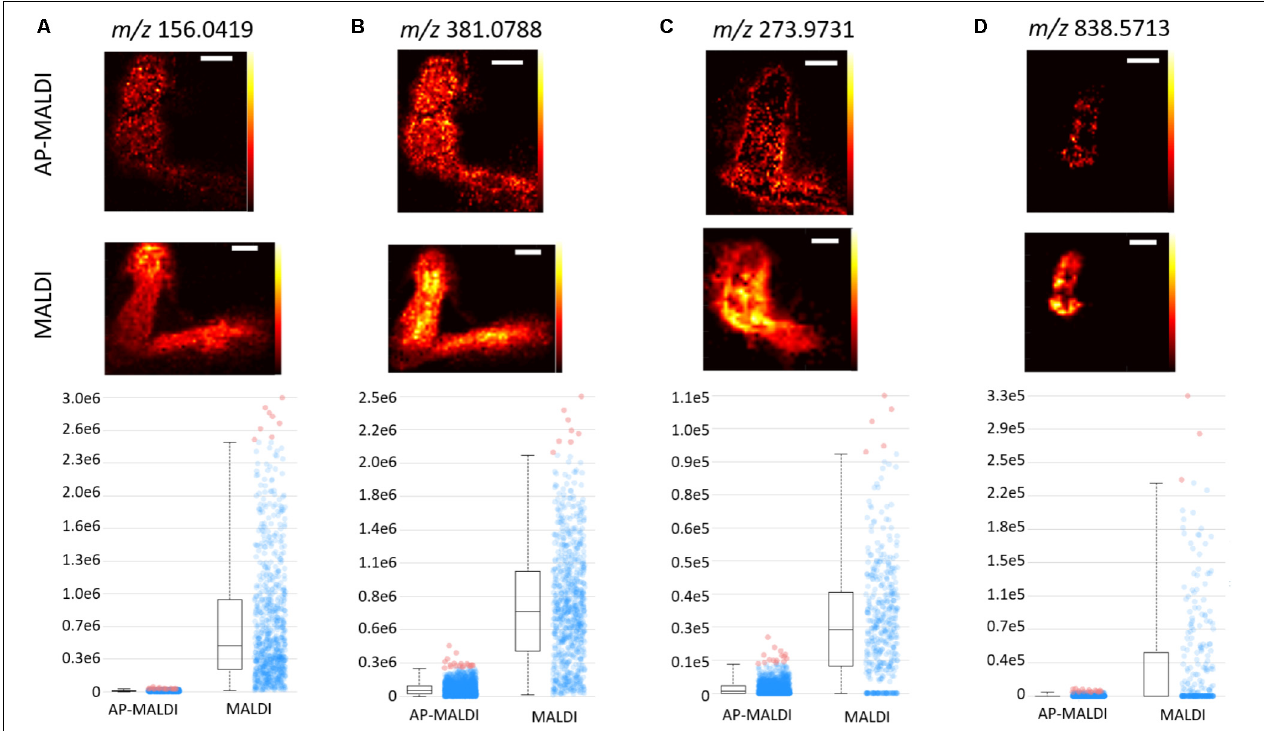
FIGURE 3 | Comparison of images detected in both the AP-MALDI and MALDI platforms. Each part in (A–D) depicts a different m/z with a ± 5 ppm window. For each part, the AP-MALDI image is shown on the top, the MALDI image in the middle, and the box and whisker plot on the bottom. (A,B) Are from the DHB matrix data and (C,D) are from the CHCA matrix data. The white scale bar corresponds to 1